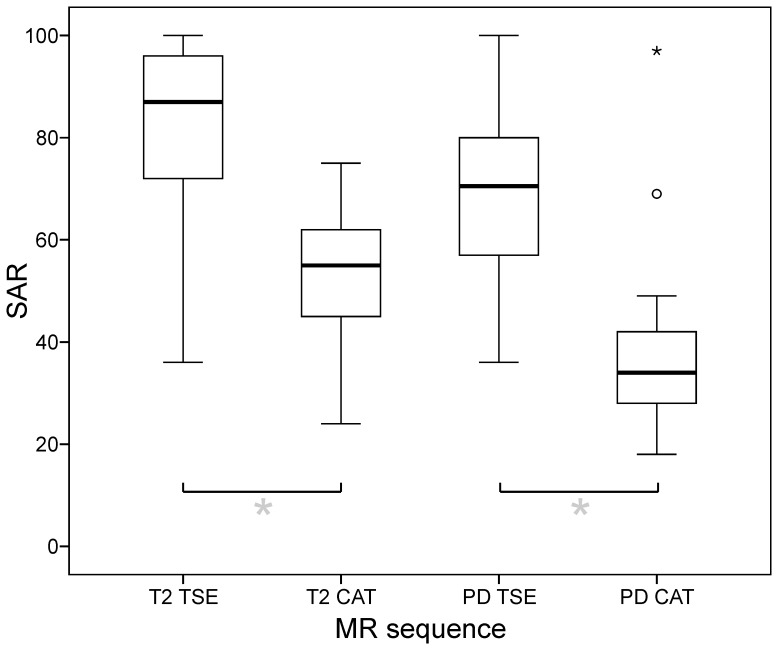
Specific absorption rate (SAR) of TSE and CAT sequences.Relative SAR reductions of CAT compared to TSE sequences was significant for both, the T2- (29.0 ± 5.7 %; p < 0.001) and the PD -contrast (32.7 ± 21.8 %; p < 0.001). (box: upper and lower quartiles, thick black line: median, whiskers: most extreme values of the interquartile range, circle: outlier, asterisk: extreme value; SAR values expressed as percentages of the effective SAR limit of 3.2 W/kg for head examinations according to IEC).